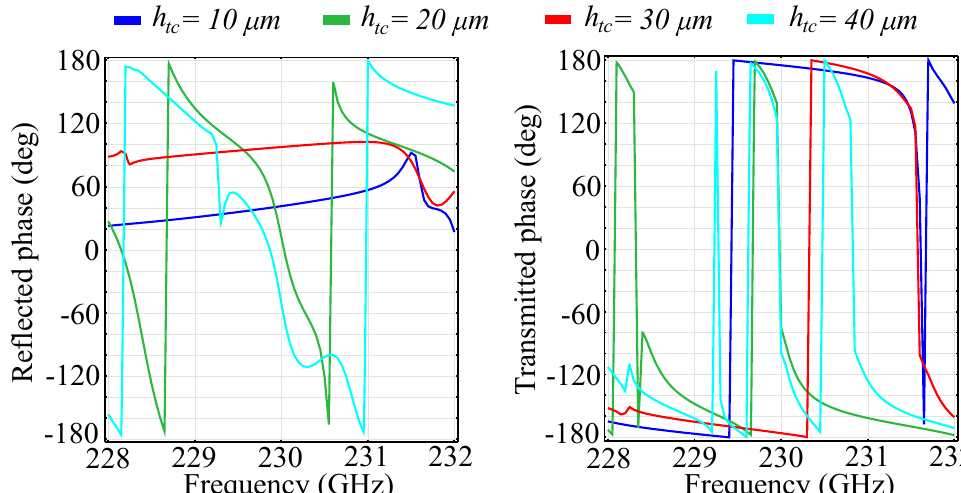
Figure 9. Simulated phase of the reflected and transmitted waves for fixed ring-cone height ( h c ) values in the silicon substrate unit cell